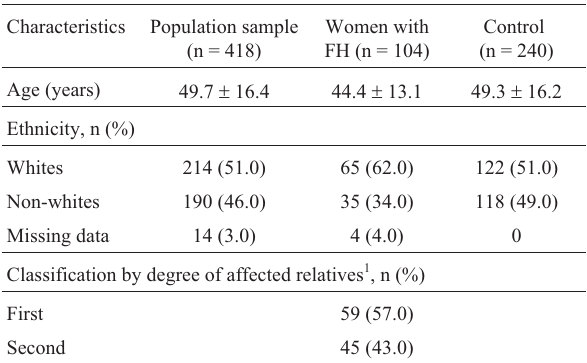
Table 1 - Descriptive characteristics of the population sample, women with family history (FH) of breast cancer and